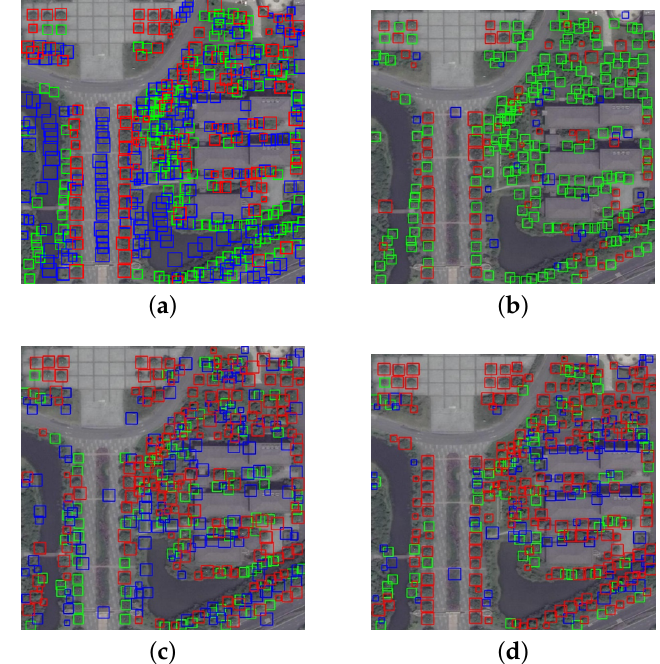
Figure 11. Results of different methods in Test Area 2: ( a ) Region-growing; ( b ) Template-matching; ( c ) Convolutional neural network; and ( d ) Progressive cascaded convolutional neural